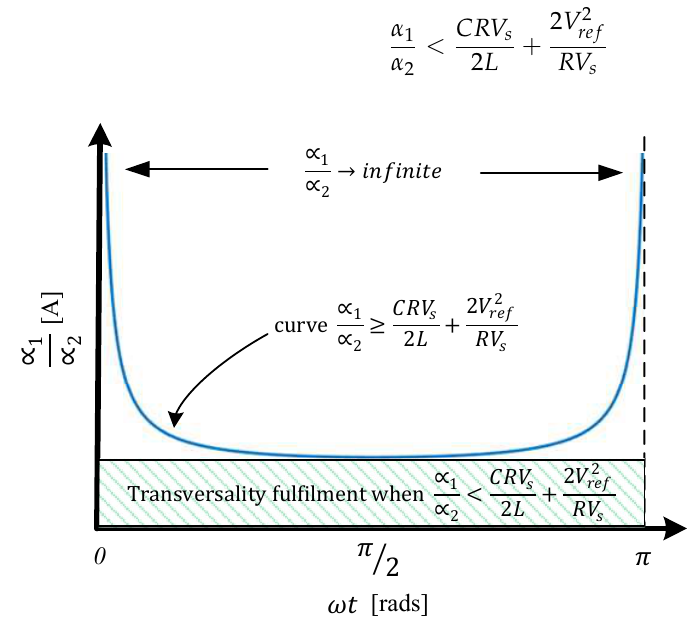
Figure 2. Graphical representation of transversality